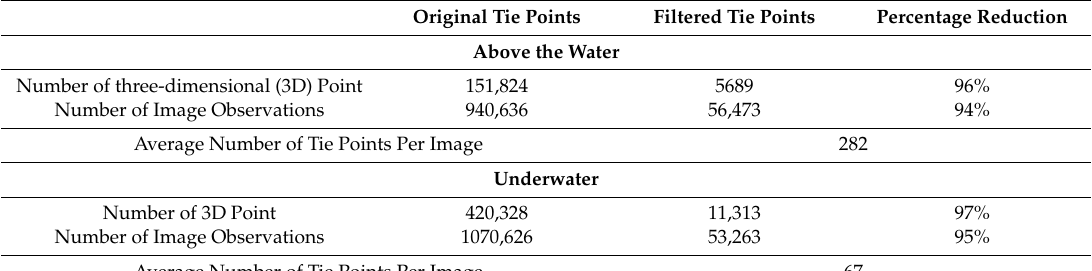
Table 2. Characteristics of filtered sparse tie point clouds above and under-the-water photogrammetric models.